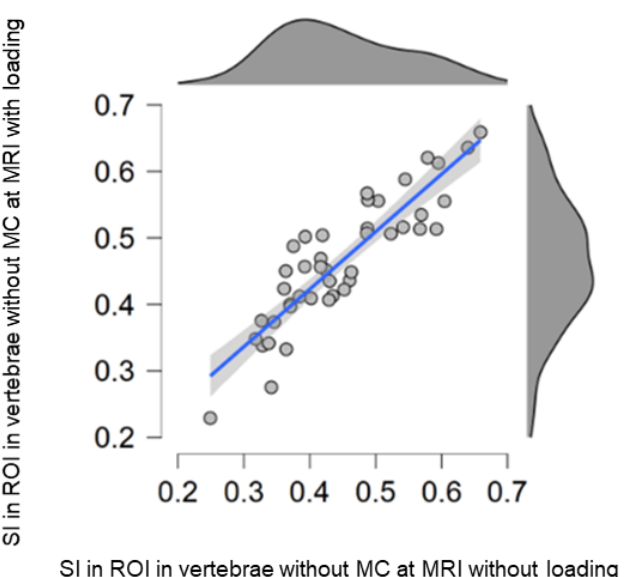
Figure 4. Scatterplot of the signal intensity (SI) in each reference ROI in vertebrae without Modic change (MC) at MRI with (y-axis) and without (x-axis) loading.